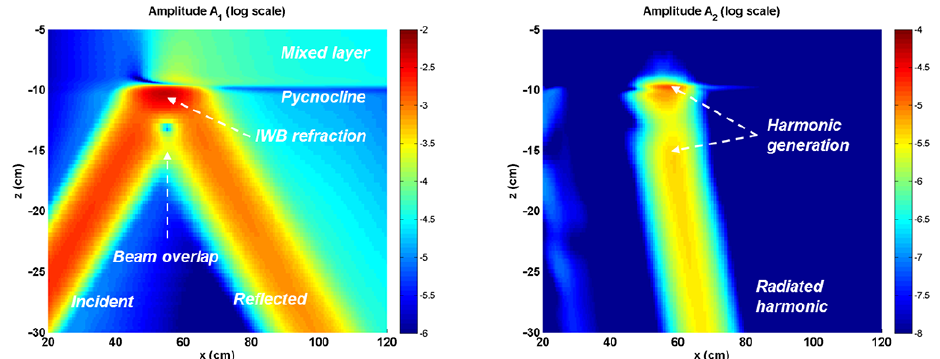
Figure 4. Kinetic energy amplitude in the incident frequency ( ω f , left) and lowest harmonic (2 ω f , right) bands for the simulation with θ = 25 degrees and r = 5, illustrating the radiated harmonic